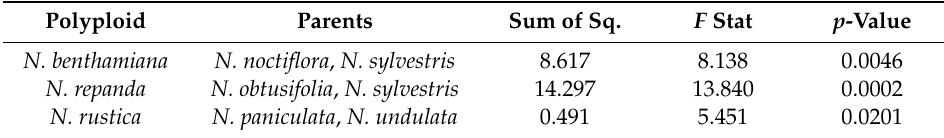
Table 1. Results of car package testing whether the parental slopes are equal for each polyploid taxon.